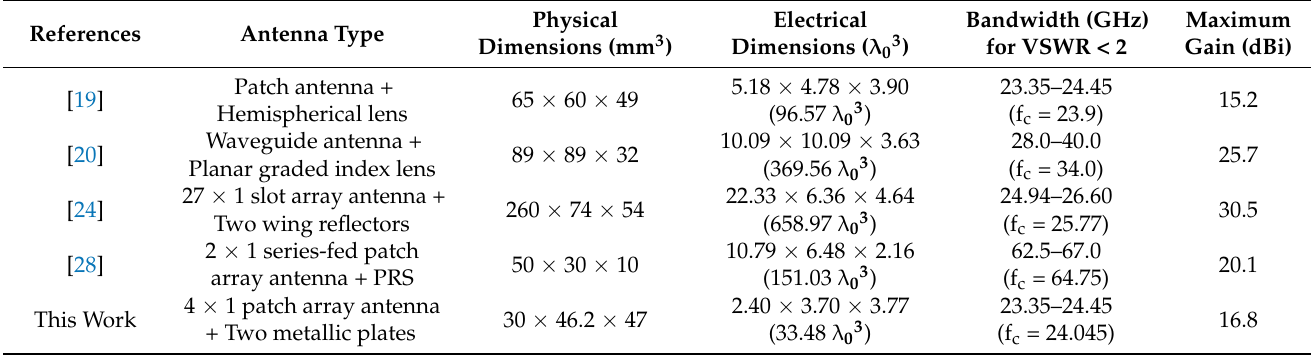
Table 1. Comparison of dimensions and performance of the proposed antenna with other antennas in the